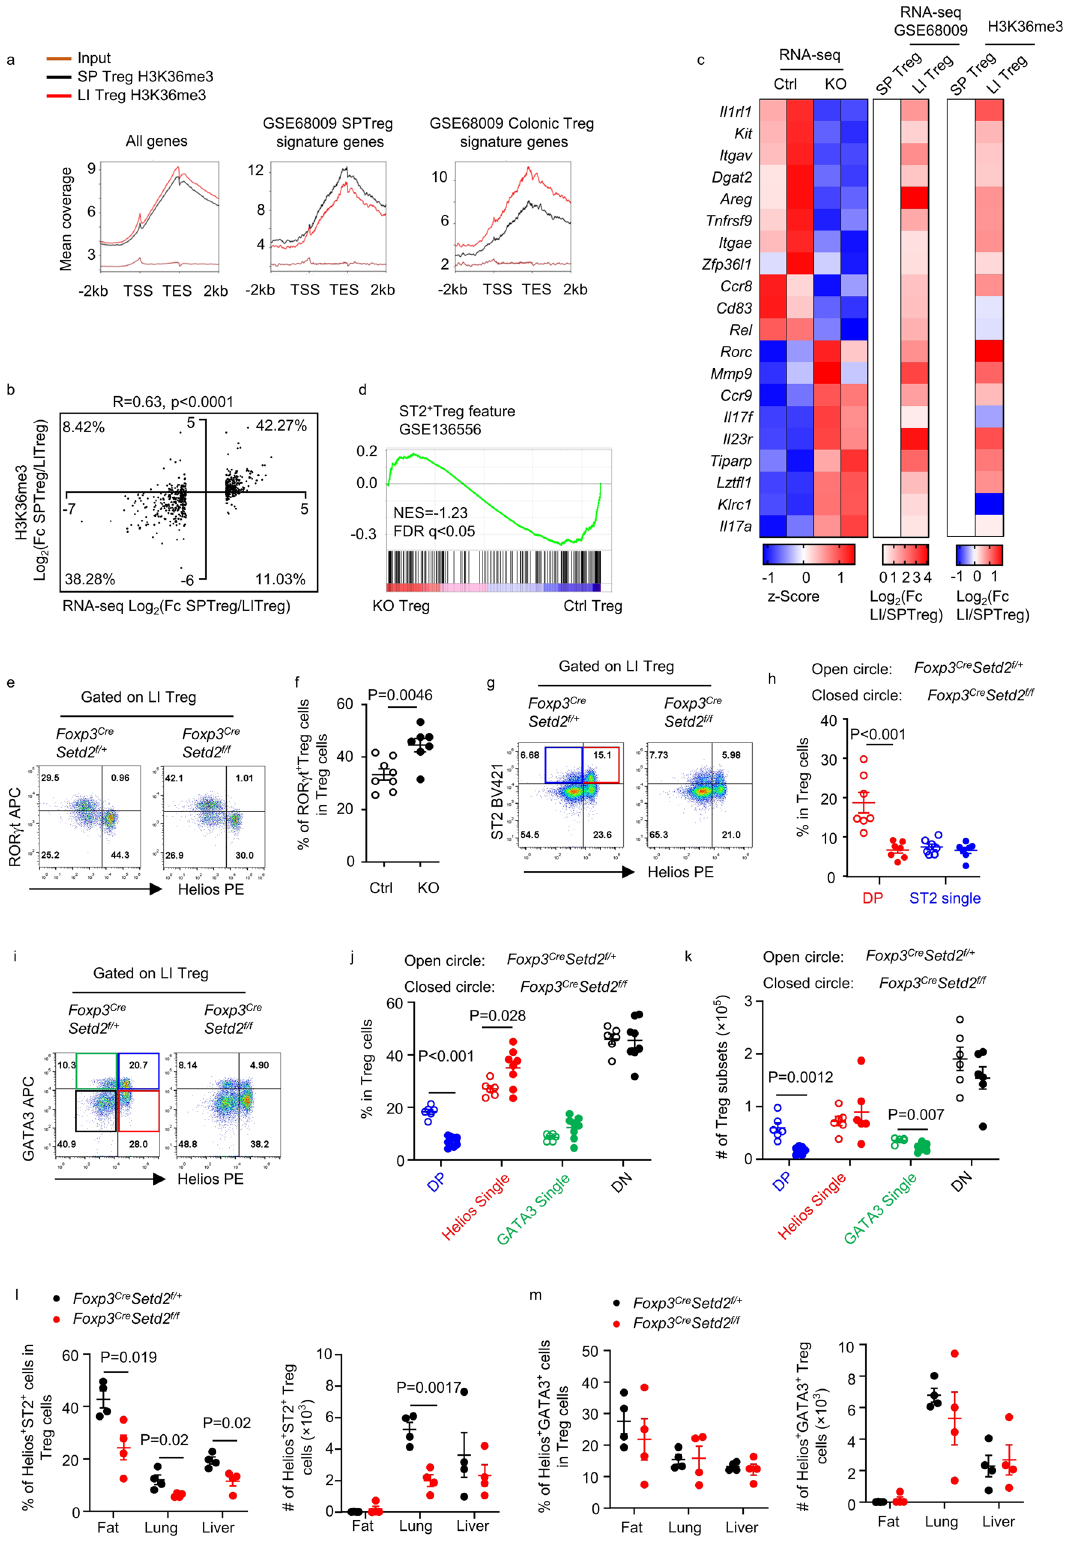
correlated with the defective function of Treg cells 42,43 , at the mRNA or protein level in Setd2-de fi cient Treg cells (Supplementary Data 3 and Supplementary Fig. 4e, f). Among the differentially expressed genes in KO intestinal Treg cells compared with control intestinal Treg cells, 57 increased and 53 decreased genes were colonic Treg signature genes (Supplementary Fig. 4g, h and Supplementary Data 3), the majority of